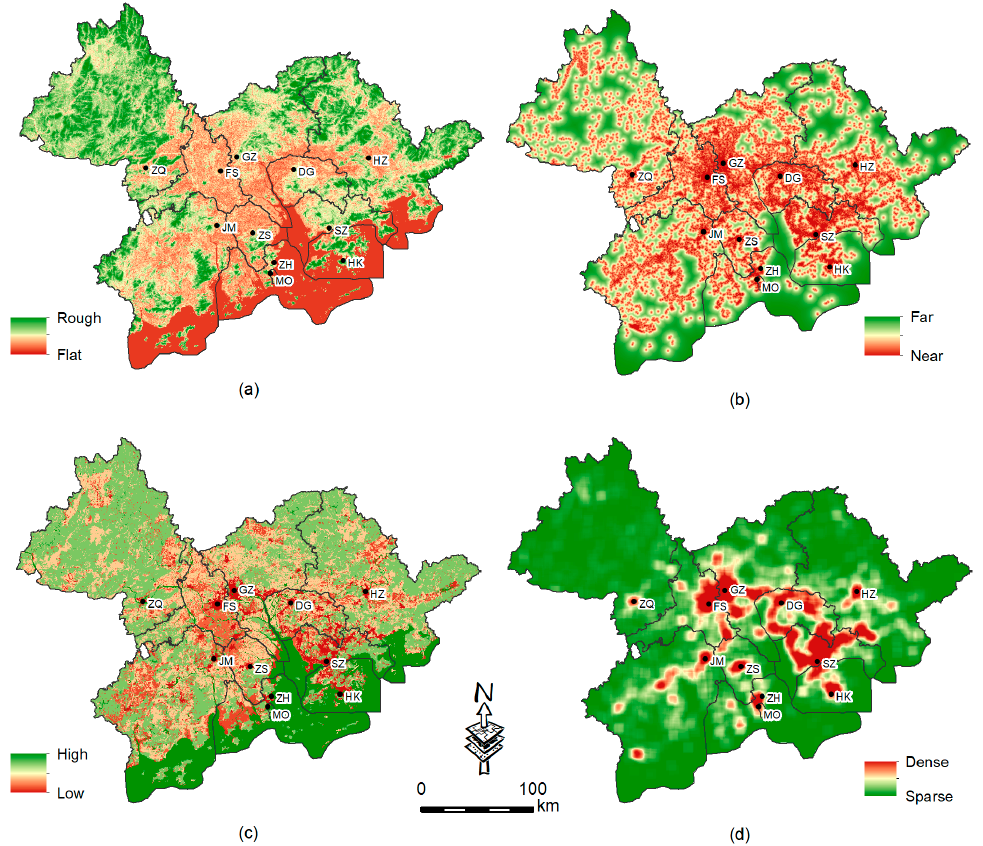
Figure 3. Spatial variables for urban growth suitability evaluation: ( a ) terrain flatness, ( b ) distance to existing cities and towns, ( c ) land-use conversion cost, and ( d ) urban landscape density.